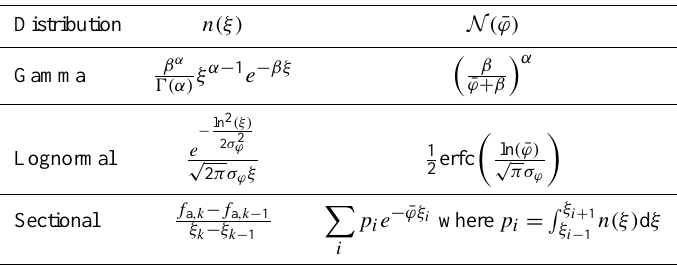
¯ ϕ n(ξ) d ξ (Rossberg, 0